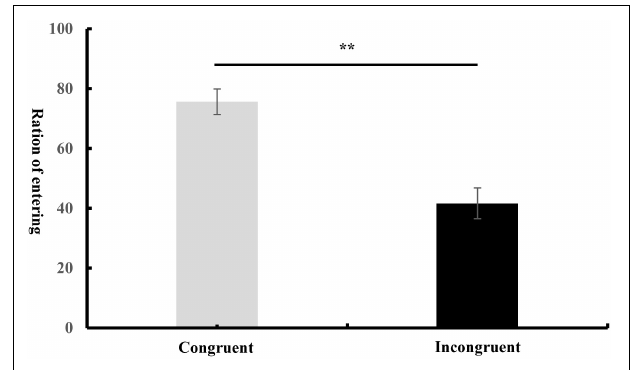
FIGURE 2 | Values of “enter” ratio under each condition. The error bars refer to the standard errors.